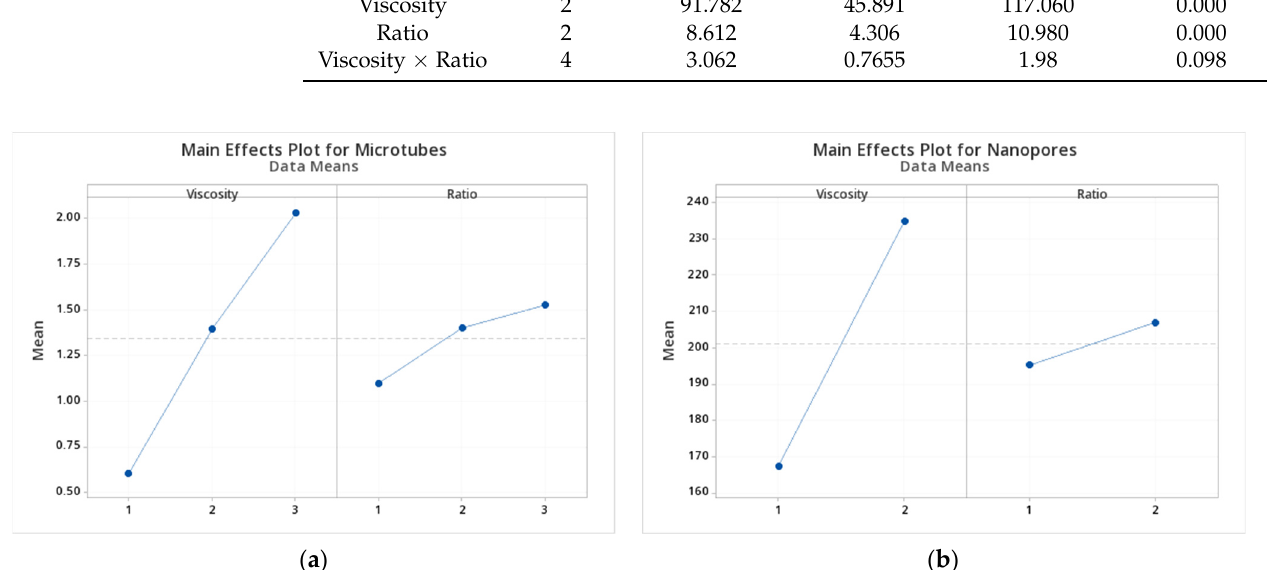
Figure 7. Main Effects Plot for Microtubes ( a ) and Nanopores ( b ).